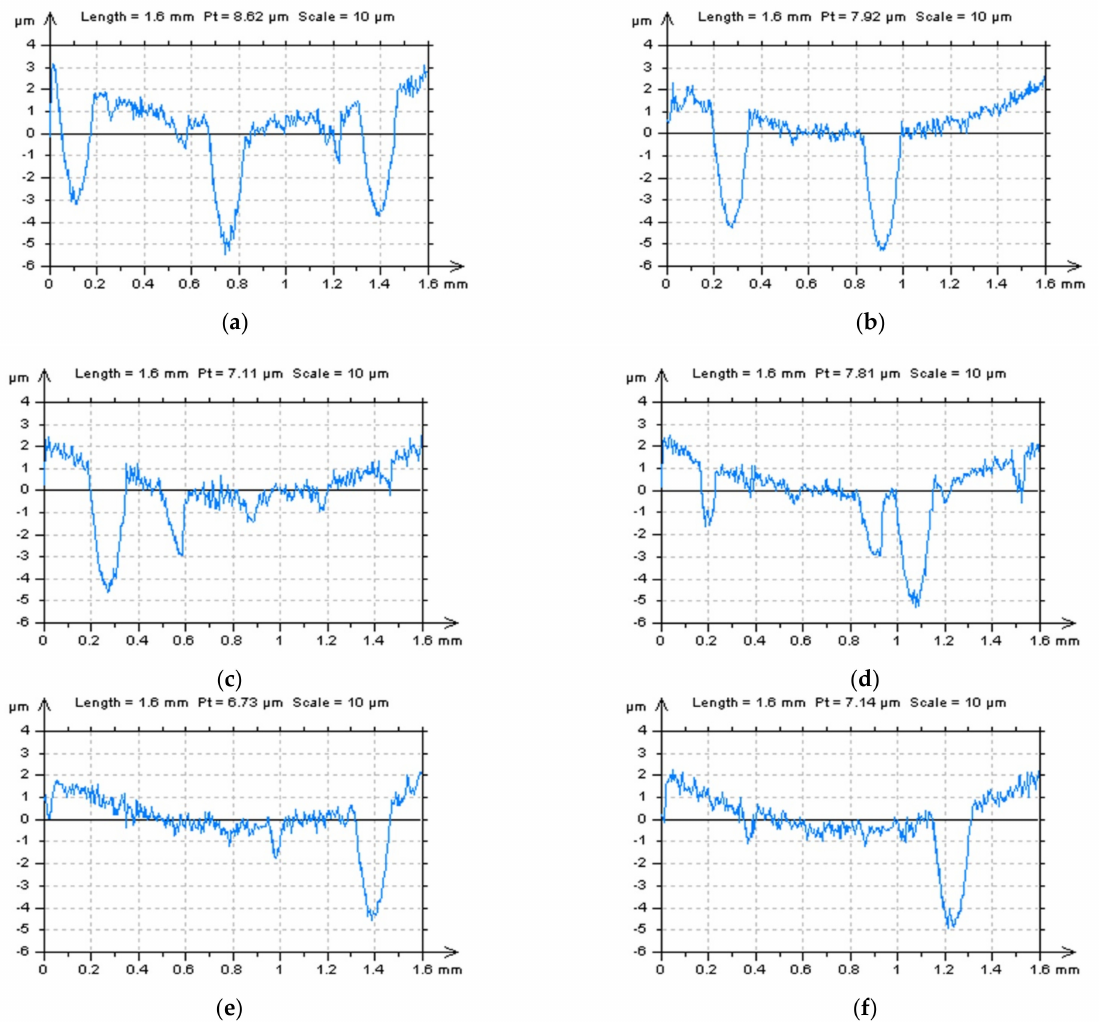
Figure 8. Examples of profiles extracted from the raw measured data of the plateau-honed cylinder liner surface topography including three dimples and two valleys ( a ), two dimples and one valley ( b ), one dimple and four valleys ( c ), one dimple and three valleys ( d ), one dimple and two valleys ( e ), and one dimple and one valley ( f